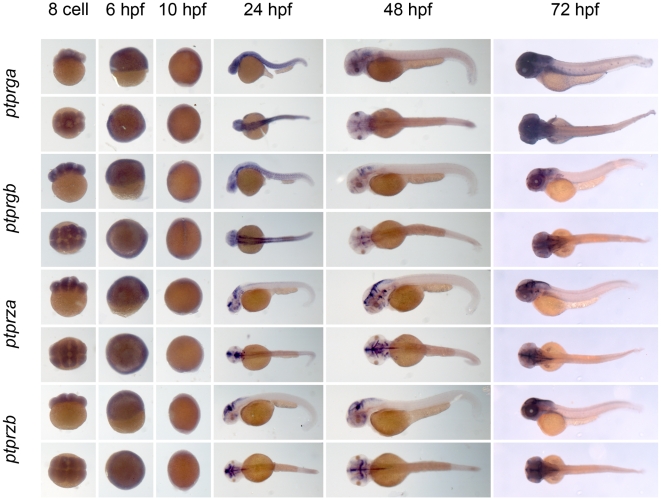
See legend to Fig. 3.